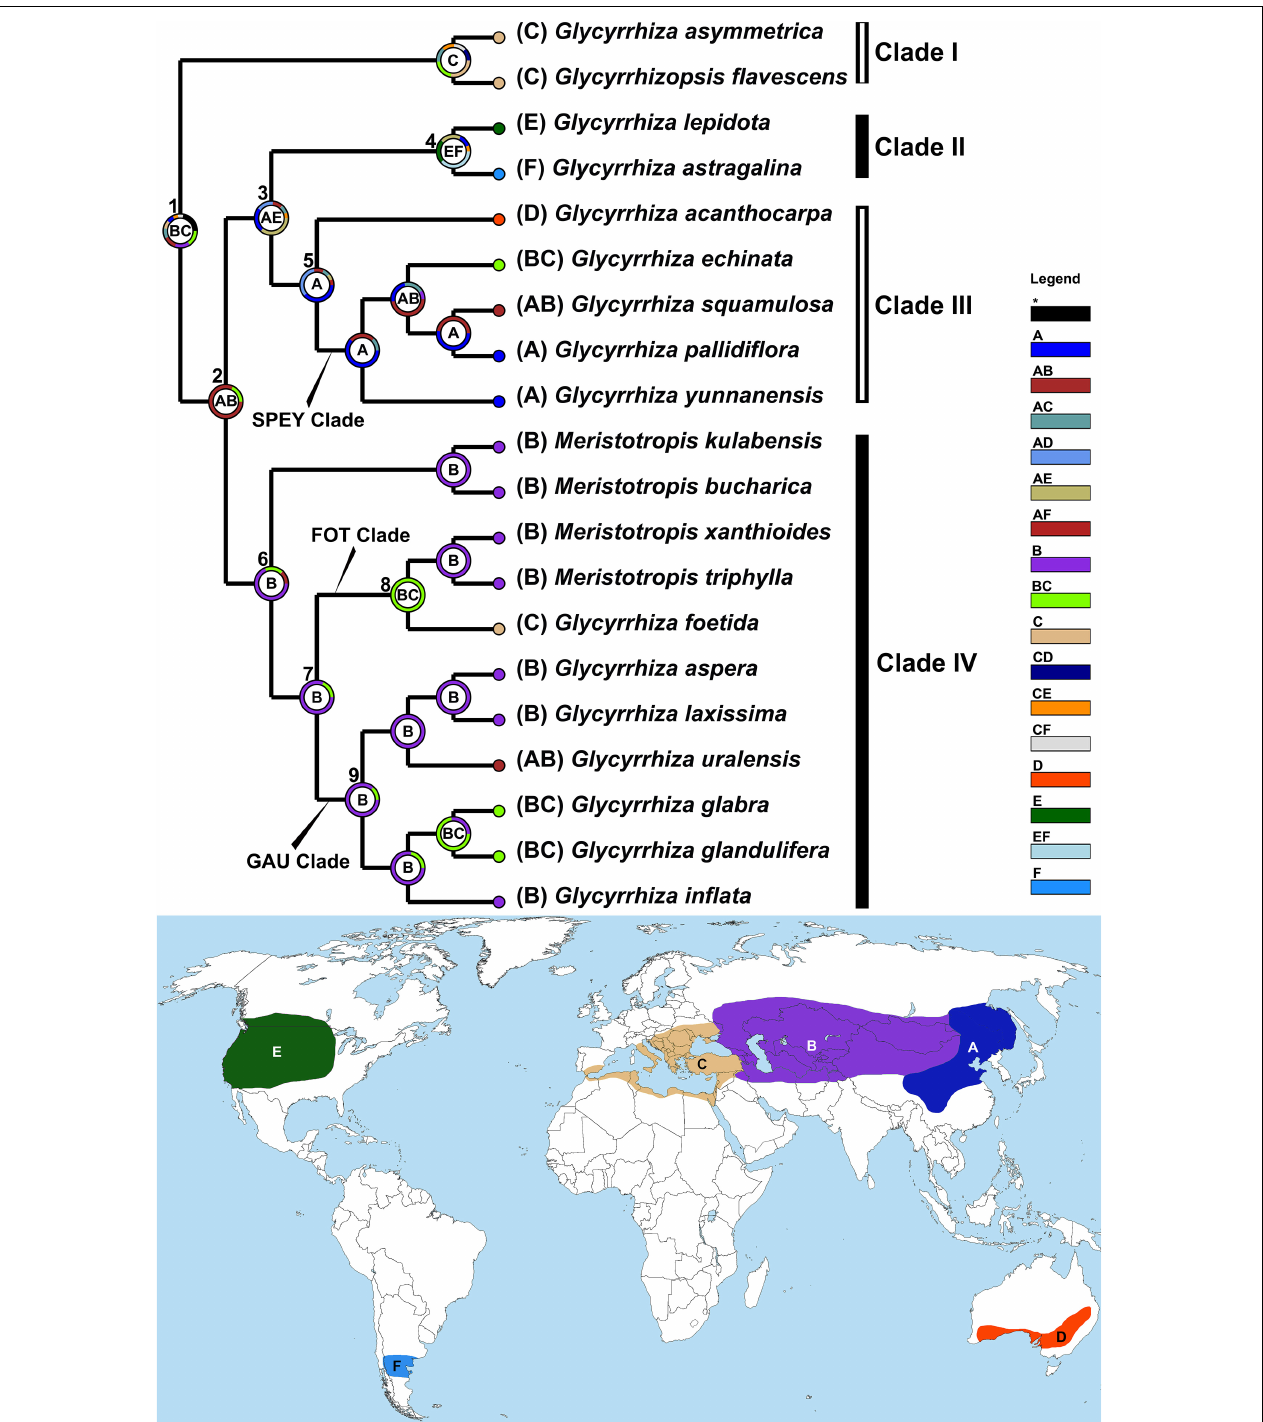
FIGURE 3 | Ancestral area reconstruction of Glycyrrhiza s.l. estimated under the DEC model implemented in RASP v.4.0 based on the tree obtained from BEAST. The most likely ancestral distributions are labeled in the circle of nodes. The map shows the coding areas in different colors. For each species with multiple accessions, the “# 1” accessions were selected for this analysis (details see Supplementary Table S1 ).